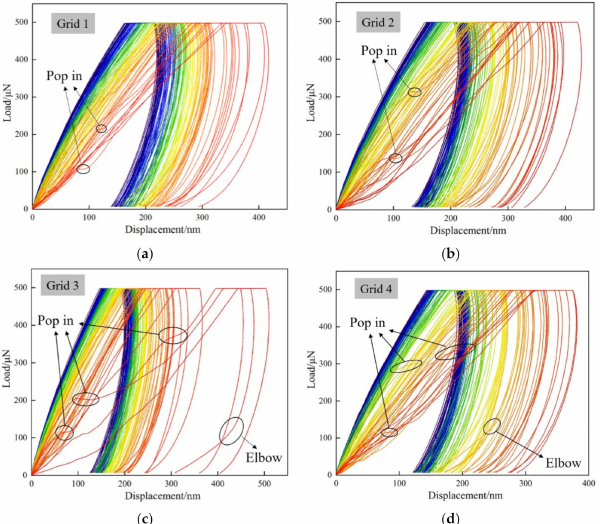
Figure 6. Load–displacement curve: ( a ) nanoindentation grid 1, ( b ) nanoindentation grid 2, ( c ) nanoin- dentation grid 3, ( d ) nanoindentation grid 4. Blue represents high elasticity and red represents low